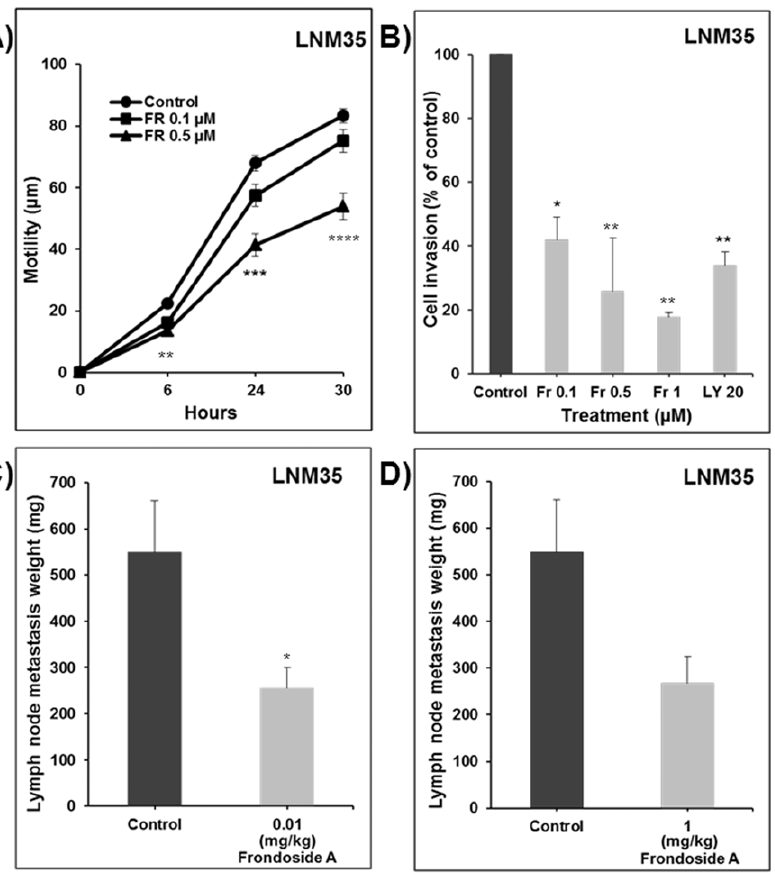
Figure 8. Frondoside A also impairs lung cancer cell migration and invasion invitro and metastasis invivo . A ) Wounds were introduced in LNM35 confluent mono-layers cultured in the presence or absence (control) of Frondoside A (0.1–0.5 m M). The mean distance that cells travelled from the edge of the scraped area for 6, 24, and 30 h at 37 u C was measured in a blinded fashion, using an inverted microscope (4 6 magnifications). Data are means 6 S.E.M. of two independent experiments. B ) LNM35 cells were incubated for 24 h in the presence or absence of Frondoside A (0.01– 1 m M) and LY294002 (20 m M). Cells that invaded into Matrigel were scored as described in Materials and Methods. Columns , mean; bars, S.E.M. Lymph nodes metastasis weight of established human lung cancer xenografts treated with Frondoside A 0.01 mg/kg ( C ) and 1 mg/kg ( D ) every day for 25 days. Columns , mean; bars , S.E.M. * Significantly different at P , 0.05, ** Significantly different at P , 0.01, *** Significantly different at P , 0.001.